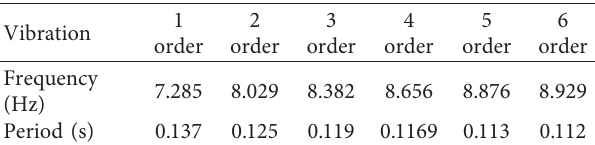
Figure 7: Comparison of the EL-Centro seismic response spectrum and the average spectrum of 20 seismic waves on medium-hard soil sites. Table 3: The first 6 natural vibration periods of brick-wood